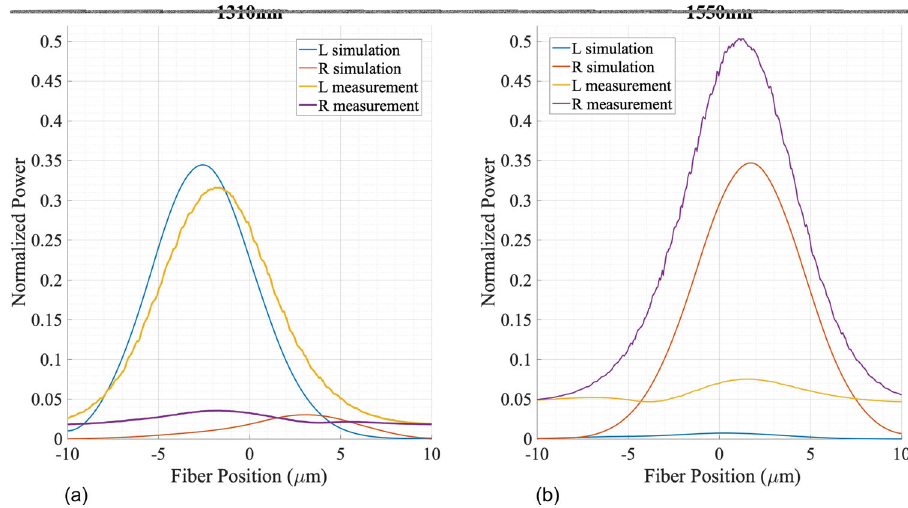
Fig. 6 Comparison of simulation and measured results for 0 ∘ (vertical) incident angle on the left (L) and right (R) ports. Measured absolute coupling ef fi ciency at a Port 1 (1310 nm) and b Port 2 (1500 nm), at the cross-section y = 0 μ m as a function of the fi ber position in the x (propagation) direction, extracted from Fig. 5 and plotted alongside simulation results.